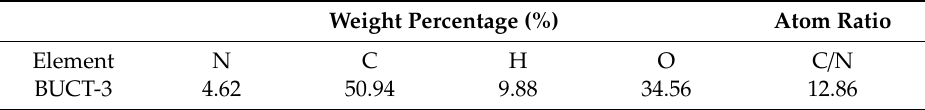
Figure 9. FTIR spectrum of BUCT-3: ( a ) Full FTIR spectrum ( b ) fingerprint region spectrum. Table 5. Element analysis of BUCT-3.